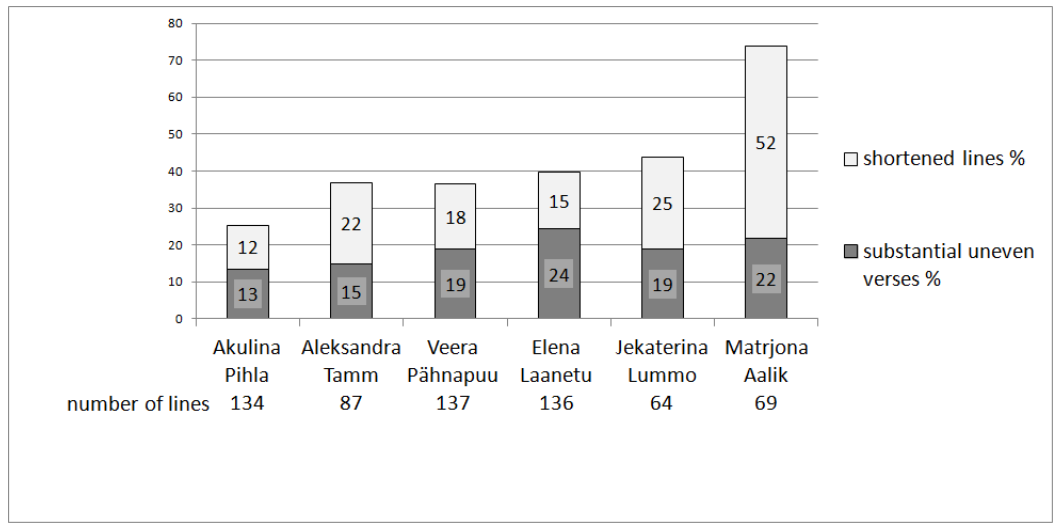
Figure 8: The percentage of substantial uneven verses and shortened lines among all performed song lines. Data of singers from whom at least 60 lines have been